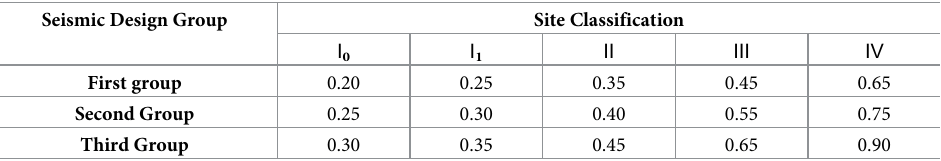
Table 1. The values of site characteristic period T g